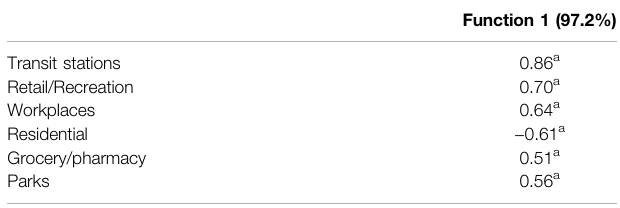
TABLE 14 | Discriminant analysis structure coef fi cients for mobility changes variables by latent class.